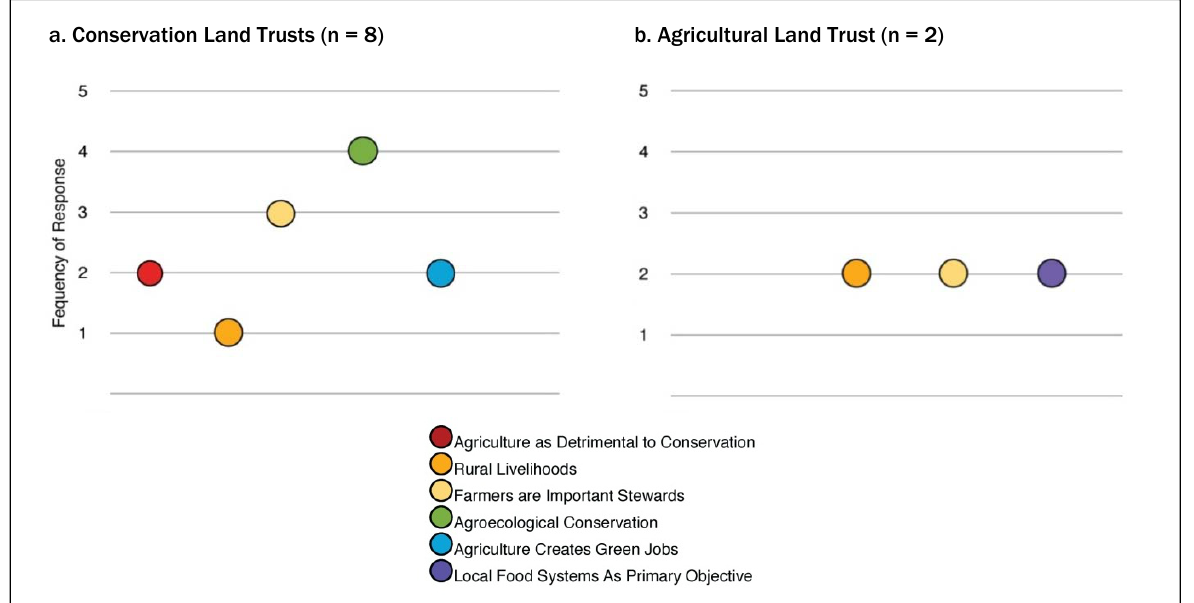
Figure 2. Land Trust Identity in Terms of Agriculture and